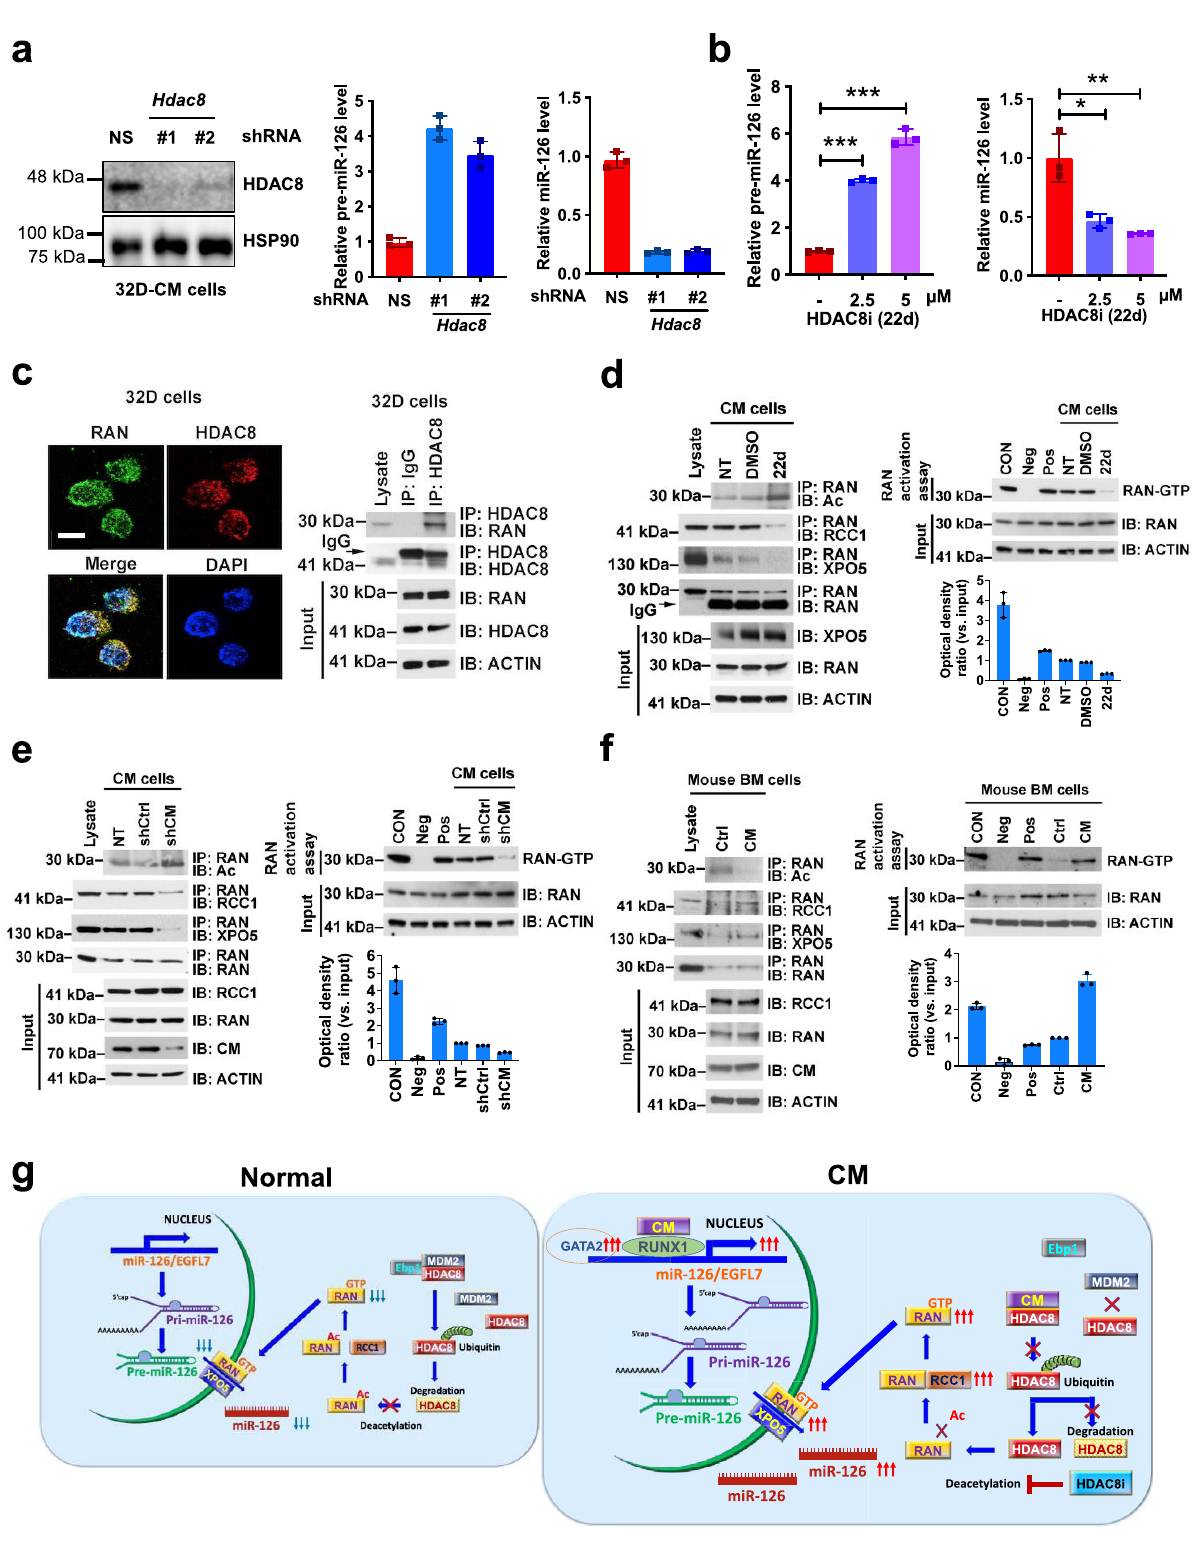
showed increased levels of phosphorylated (p)-ERK, increased p-MYC (S62) and total MYC protein (Fig. 4b). Deletion of miR- 126 reversed these effects in that increased Spred1 , Plk2 in LSK (Fig. 4a), and decreased p-ERK, p-MYC (S62), and MYC protein levels were detected in CM/miR-126 Δ / Δ Lin − BM cells (Fig. 4c). Similar results were obtained by knocking down miR-126 using a lentiviral vector (GFP + ) expressing miR-126-3p shRNA